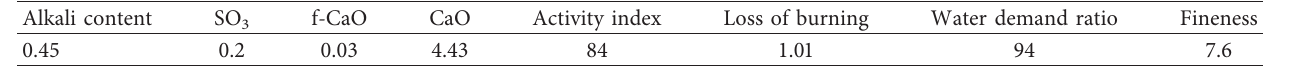
Table 1: The main technical index of fly ash (%).